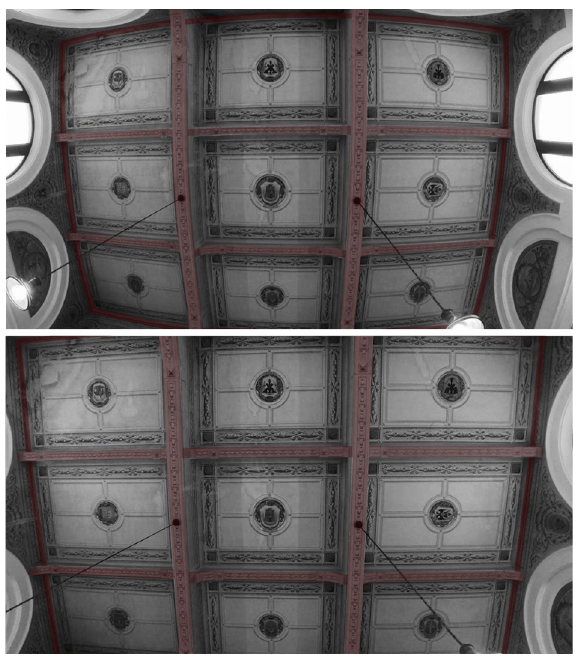
Figure 2 . Corresponding frames of the video with highlight joists before and after “linear” FOV control in Insta360 Studio. The lens is a wide-angle type, and the diaphragm has an aperture of F/2.8. Despite this kind of device doesn’t permit to modify settings as a professional camera (ISO, Aperture.